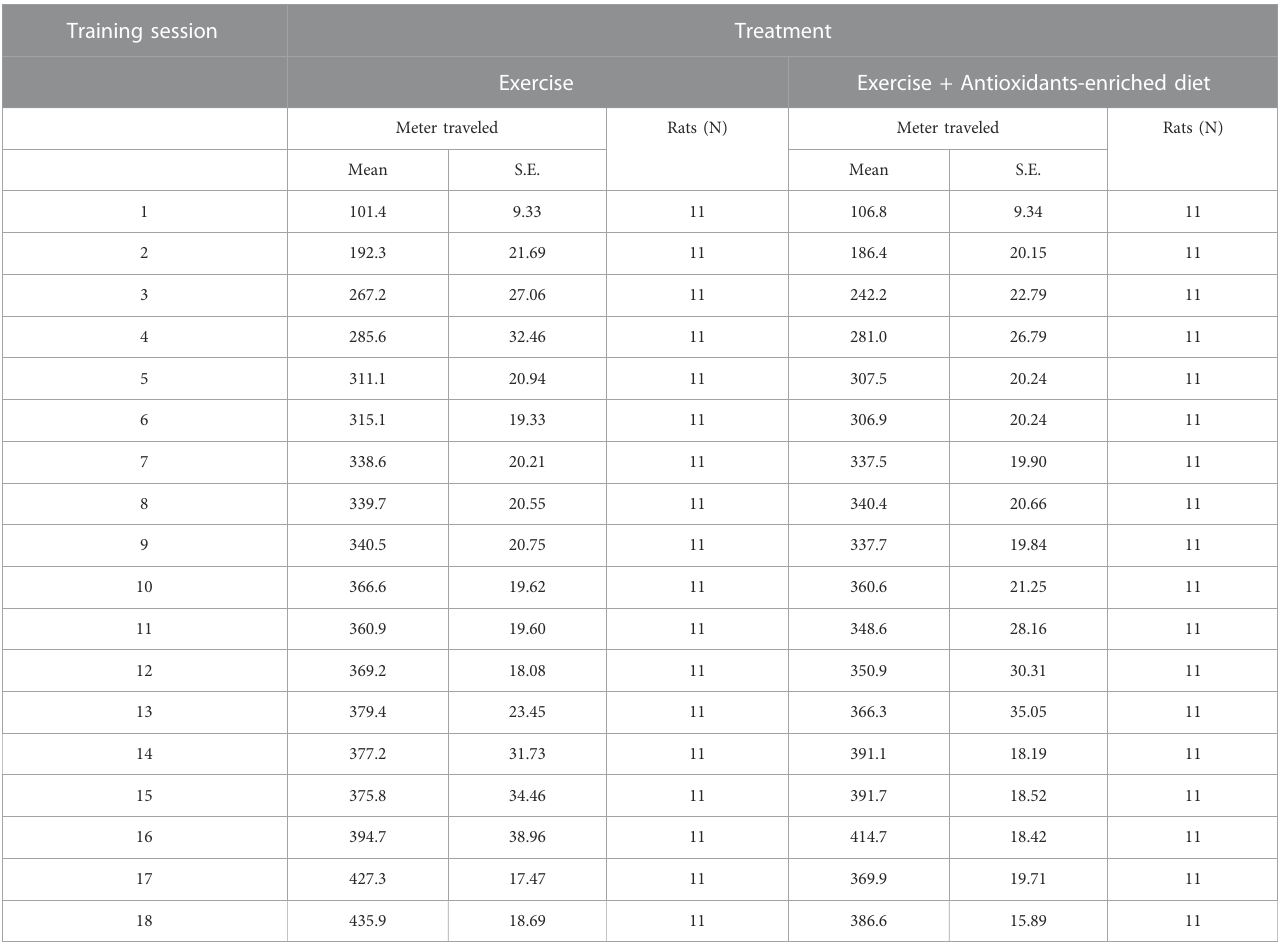
TABLE 1 Distance travelled by rats at the end of every exercising session. Training